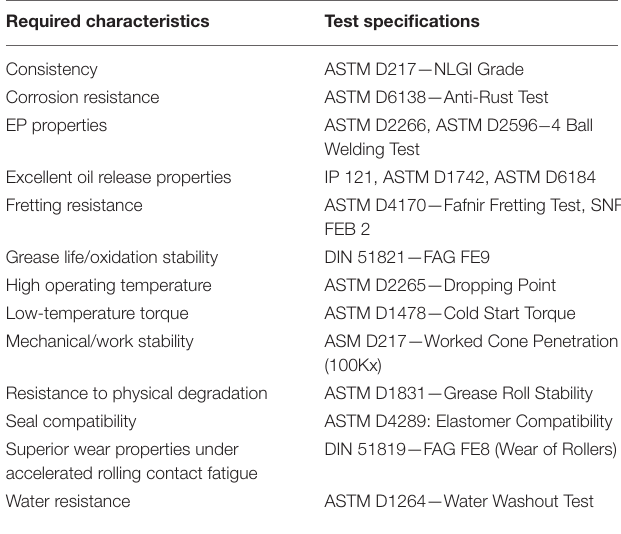
TABLE 2 | Selected test specifications relevant to wheel bearing lubrication in electric vehicles (Andrew,